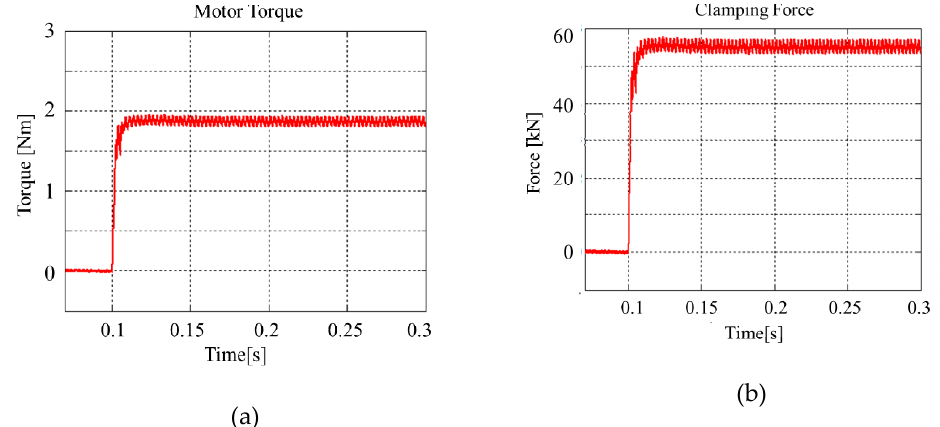
Figure 9. Simulation result of mechanical output without maximum torque per ampere (MTPA): ( a ) motor torque and ( b ) clamping force.